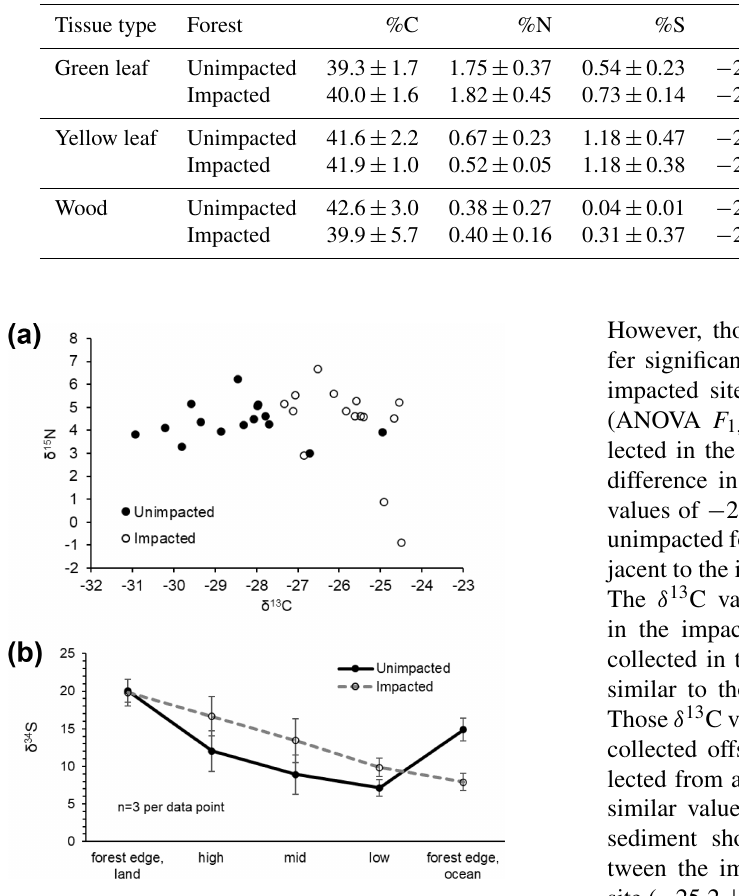
Figure 3. CNS isotopic compositions of green leaves of A. marina from the unimpacted and impacted sites. All samples were collected in 2018, 32 months after the dieback. (a) Leaf δ 13 C and δ 15 N val- ues. (b) Leaf δ 34 S values across the intertidal zones. Error values are